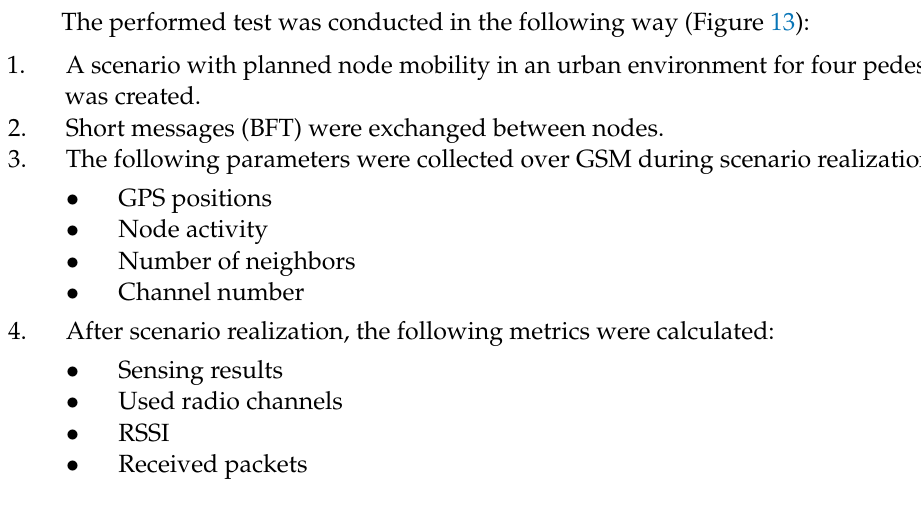
Figure 12. Radio node components.